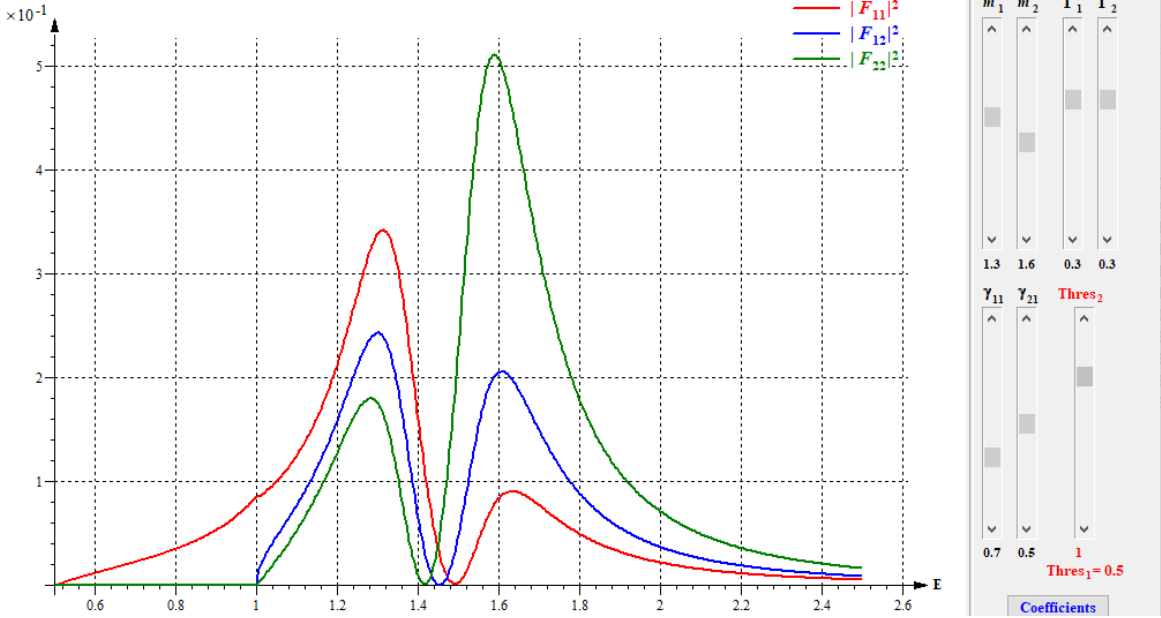
Figure A4. K -matrix scattering amplitudes . Figure A4. K-matrix scattering amplitudes. The values of the BW parameters (entered with scroll-bars) in the screenshot in Figure A5